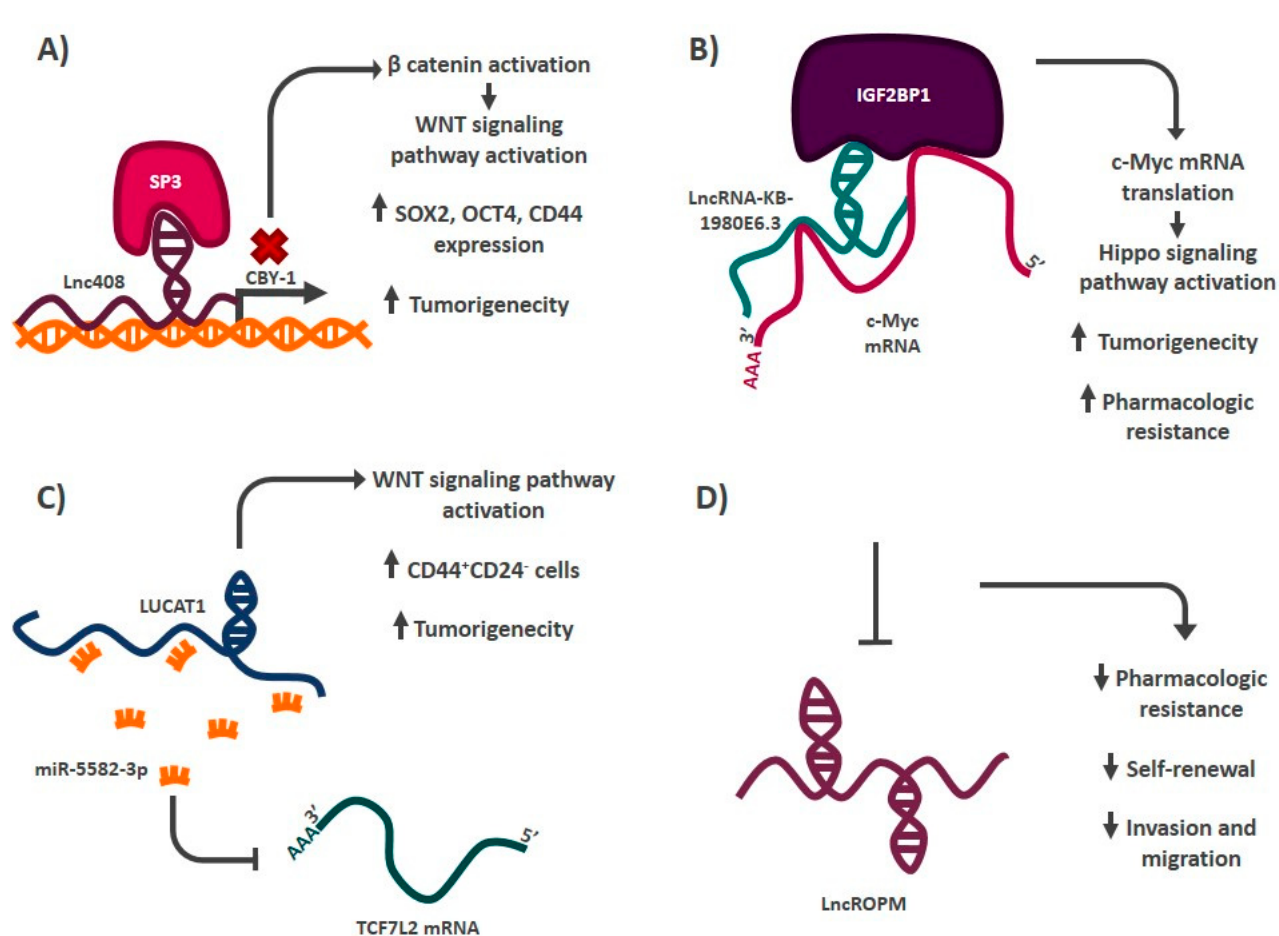
Figure 3. Mechanism of action of some stemness regulatory lncRNAs in breast cancer. ( A ) Lnc408 acts as a guide by recruiting chromatin remodelers to the promoter region of CBY-1, preventing its expression, and allowing the activation of the WNT signaling pathway. ( B ) LncRNA-KB-1980E6.3 forms an RNA–protein complex that stabilizes the mRNA of the C-MYC oncogene, allowing its translation, which generates the acquisition of some characteristics that define the stem phenotype. ( C ) LUCAT1 is a lncRNA that acts as a sponge of miR-5582-3P, promoting the activation of the WNT signaling pathway and thus increasing the proportion of CD44 + CD24 − cells. ( D ) Inhibition of LncROPM decreases some of the characteristics that define the stem phenotype, although its mechanism has not yet been